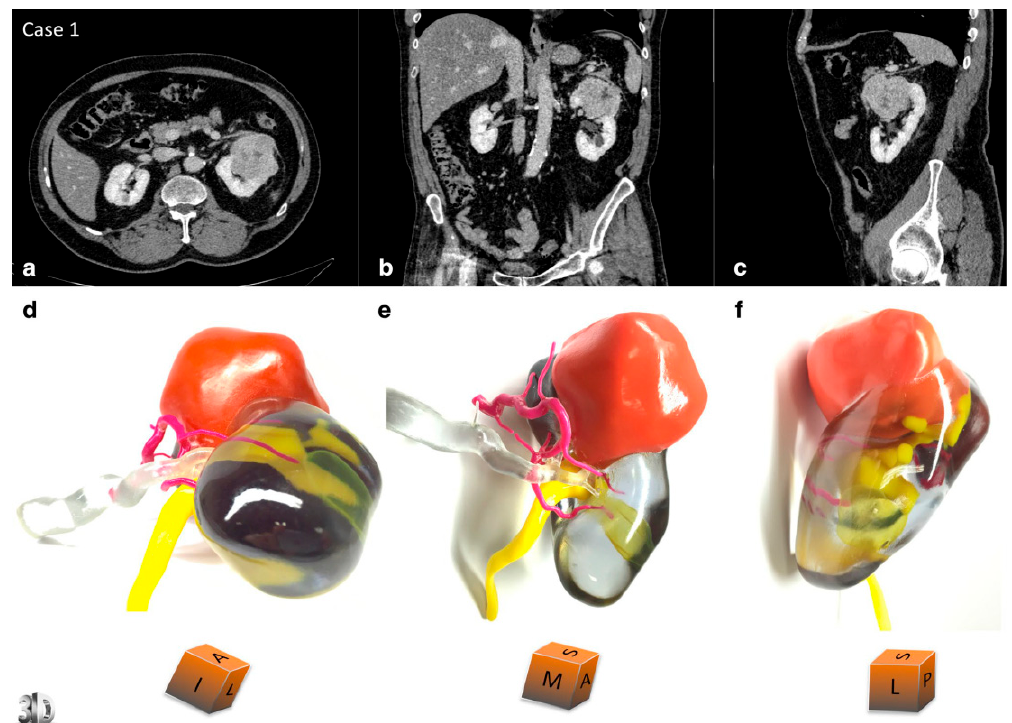
Figure 4. 3D-printed model of a 67-year-old male with renal tumour at the upper pole of left kidney. Comparative views of the CT scan at the nephrographic phase (( a ) axial, ( b ) coronal, and ( c ) sagittal planes) and corresponding views of the physical model (( d ) superior and median view, ( e ) median and anterior view, and ( f ) lateral view). An inferior polar cyst is also displayed on this model (translucent yellow). The cubes show the 3D-printed model orientation in space (I = inferior face, A = anterior face, L = lateral side, S = superior face, P = posterior face, M = median side). The patient underwent a left radical nephrectomy for a 65 × 56 × 42 mm clear cell renal cell carcinoma, pT1bN0Mx, Fuhrman grade 3. The arterial tree is presented in opaque magenta, the collecting system in opaque yellow, and opaque orange for tumour display. The renal vein and renal parenchyma are kept translucent to allow the best visualisation of the relationships between the renal tumour and surrounding structures. Reprinted with permission from Bernhard et al. [6].